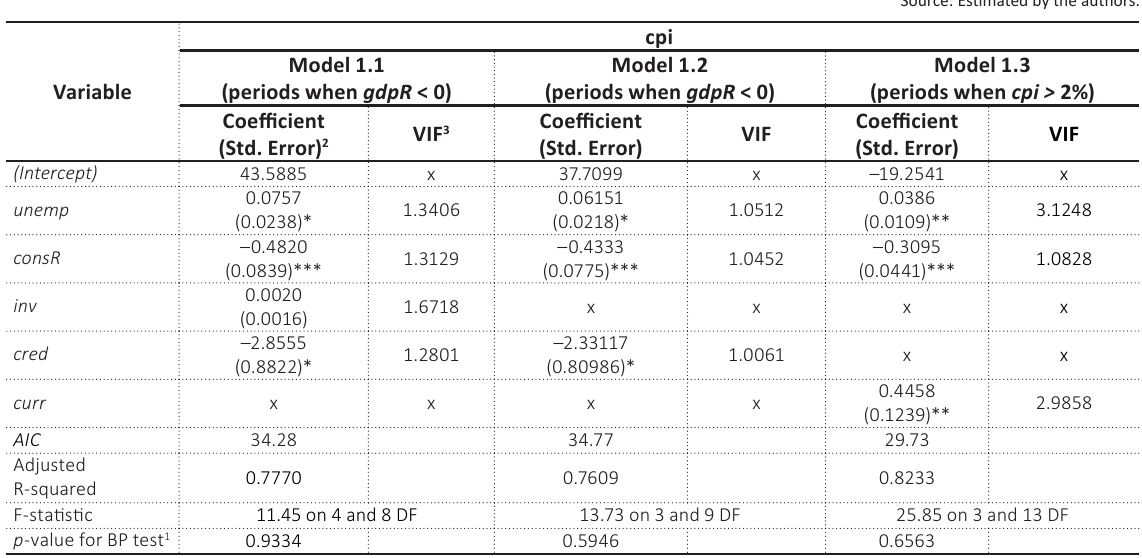
Table 4. Summary statistics for CPI regression